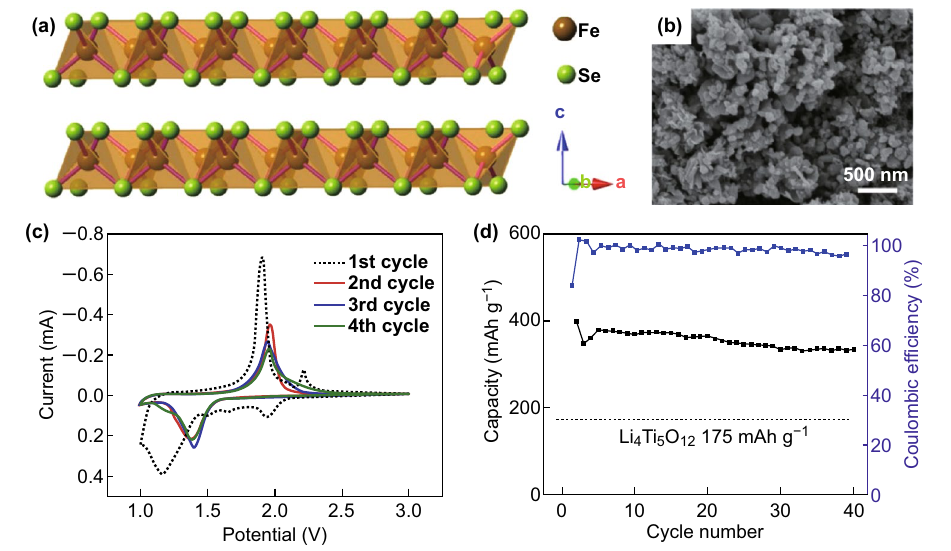
Fig. 5 a Schematic of α-FeSe reveals the crystal structure of the layered structure. b SEM image of the sample. c The first four consecutive CVs of the α-FeSe@C composite have a scan rate of 0.1 mV s −1 . d Cycle performance of the composite at a current density of 40 mA g −1 . Adapted from Ref. [51] with permission. Copyright 2014,